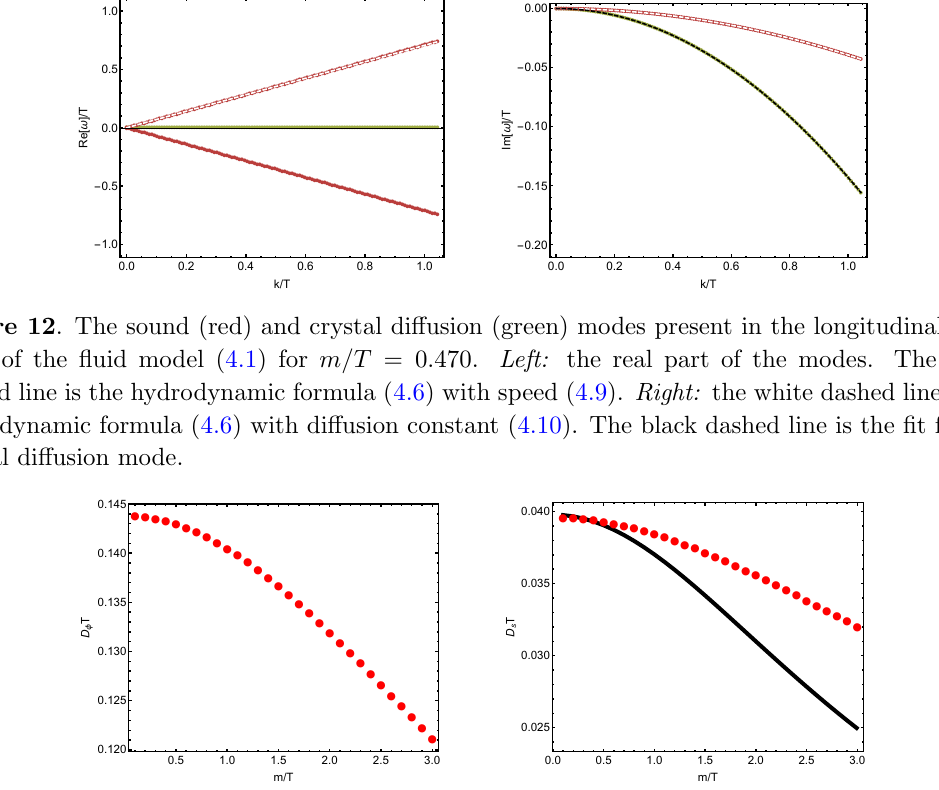
Figure 13 . Left: the crystal di(cid:11)usion constant of the mode (4.11) in function of the dimensionless SSB parameter m=T . Right: the sound attenuation constant D s in function of m=T . The black line is the hydrodynamic formula (4.10). Within the precision of the numerical data, the agreement is good for m=T (cid:28)